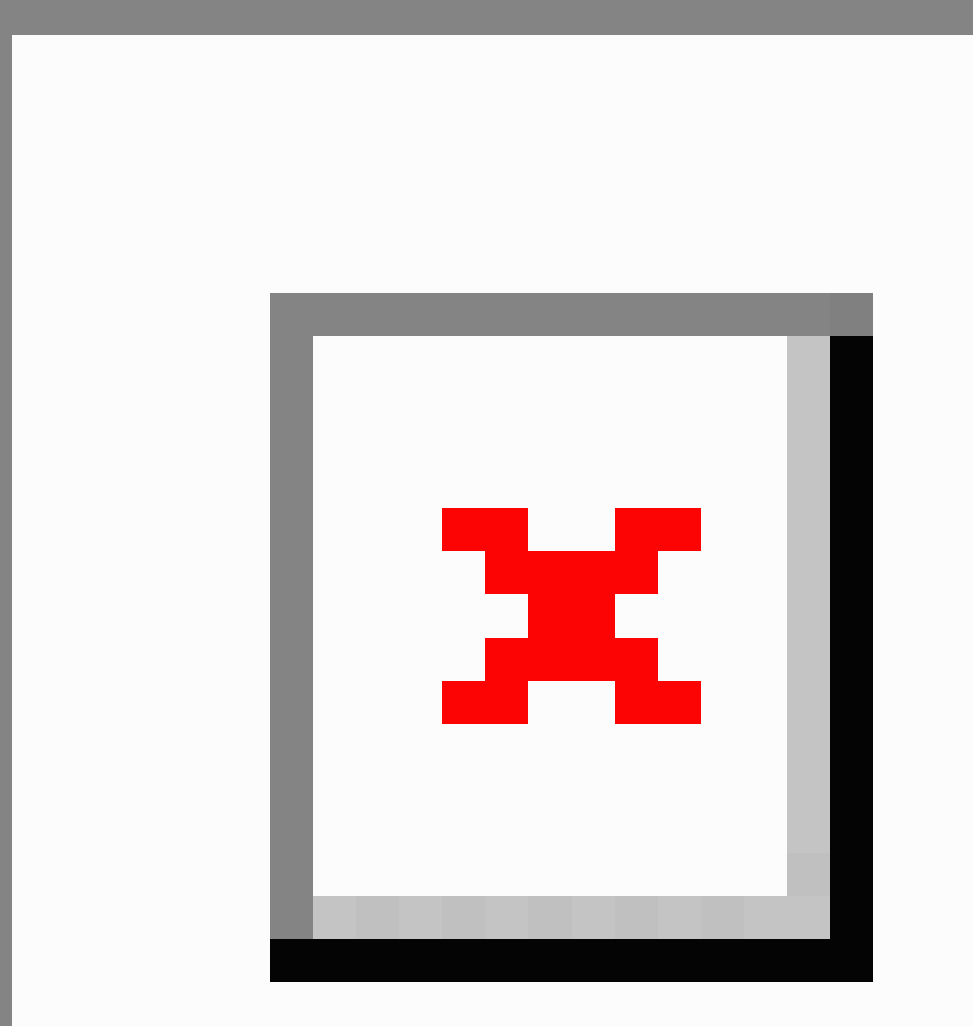
Victor OkhueseJMIR PUBLIC HEALTH AND